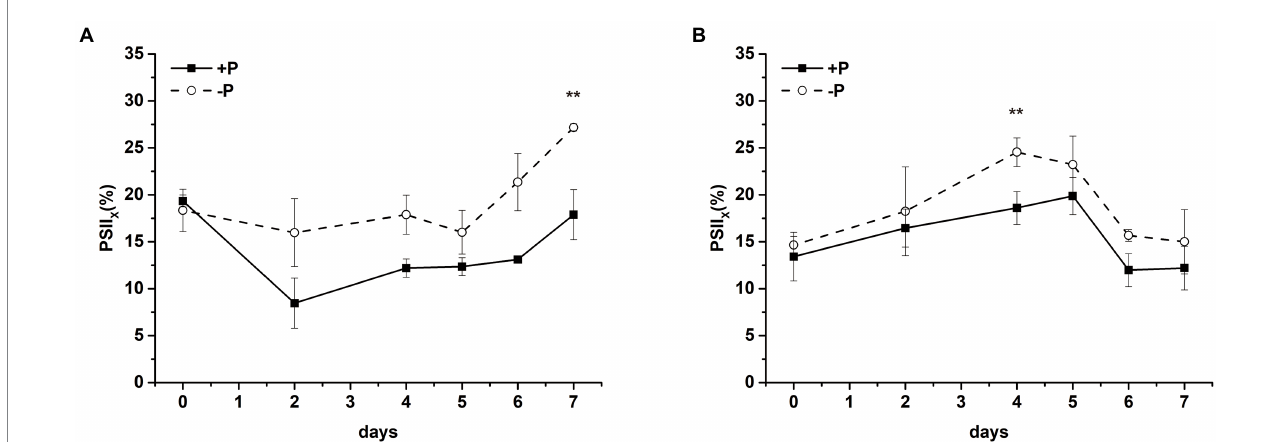
FIGURE 7 Proportion of PSII X centers of S . costatum (A) and P . globosa (B) in +P and − P groups for various periods of time. Error bars show the mean ± standard error (SE) of triplicate treatments. Superscripts indicate significant differences between +P group and − P group according to a two-way ANOVA with a post-hoc test (** p < 0.01).